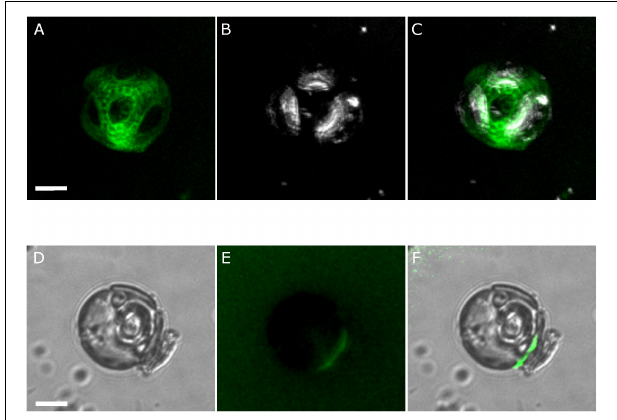
FIGURE 7 | Detailed characterization of the extracellular polysaccharide layer in C. braarudii. (A) A partially-decalcified C. braarudii cell stained with the lectin FITC-ConA (green). A 3D projection generated from a Z-stack is shown. (B) The same cell showing the position of three remaining coccoliths (white). (C) Merged image indicating that the ellipsoidal intervals in the FITC-ConA staining correspond to the position of the three remaining coccoliths on the cell surface. An additional coccolith corresponding to the central ellipsoid region has become detached. (D) Differential interference contrast microscopy image of a recalcifying decalcified C. braarudii cell. The position of an internal coccolith and a newly-secreted external coccolith can be seen. (E) Epifluorescence image of the same cell stained with FITC-ConA showing a region of polysaccharide at the cell surface corresponding to the position of the coccolith. Note that this cell has lost its external polysaccharide layer. (F) Merged image. Scale bars represent 5 µ m.